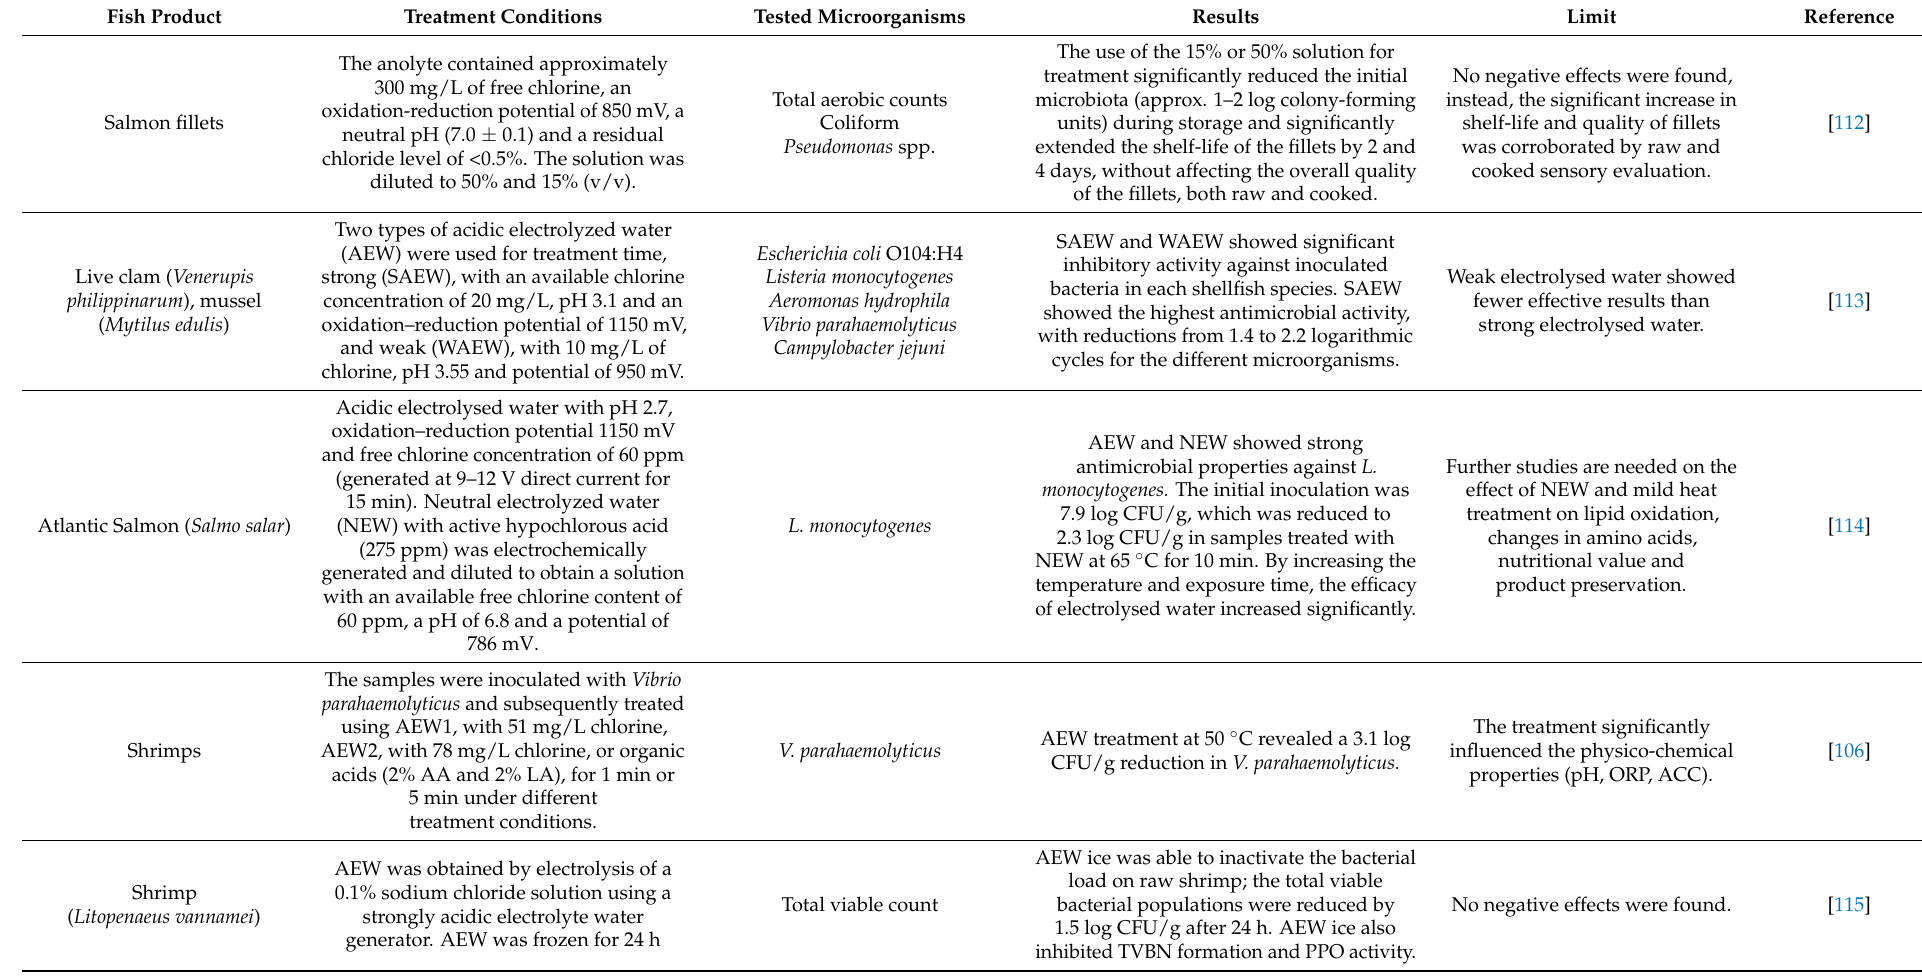
Table 4. Application of electrolyzed water (EW) technology to fish products; main results and limitations of the technology considered. Fish Product Treatment Conditions Tested Microorganisms Results Limit Reference